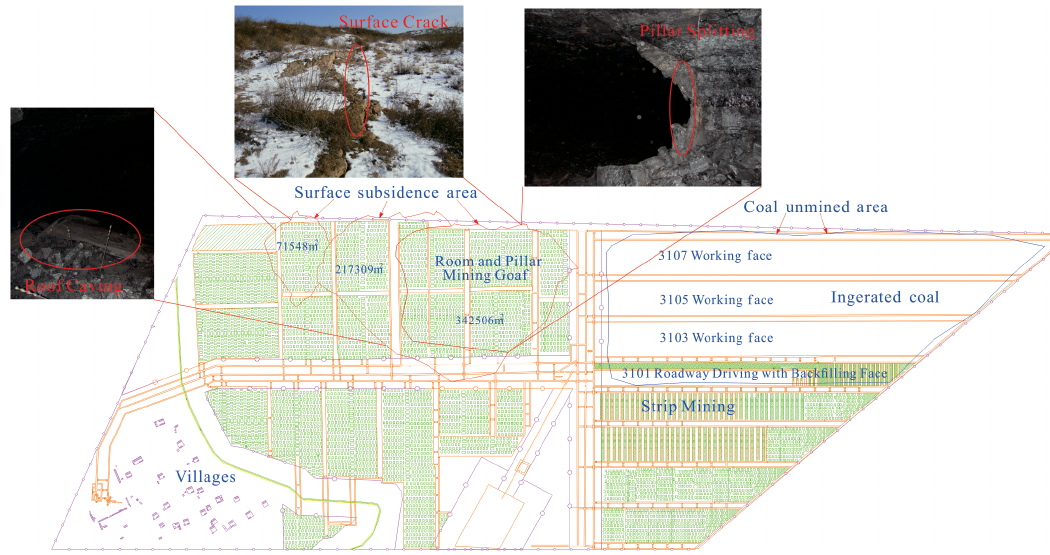
Figure 1. Surface subsidence induced by room and pillar mining and working face